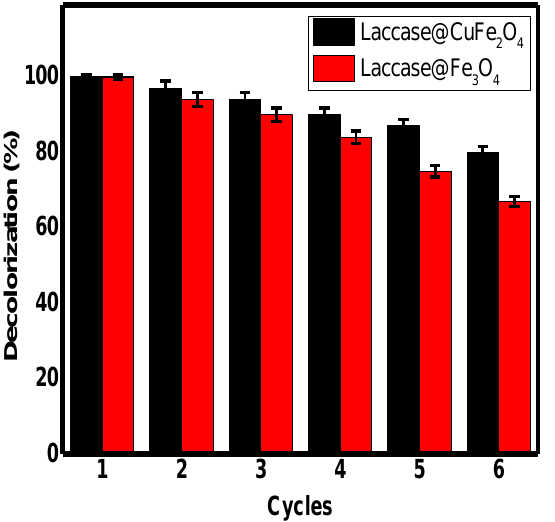
Figure 6. The reusability of CuFe 2 O 4 nanoparticle-immobilized laccase for DR23 biodegradation up to six successive cycles in optimum conditions.